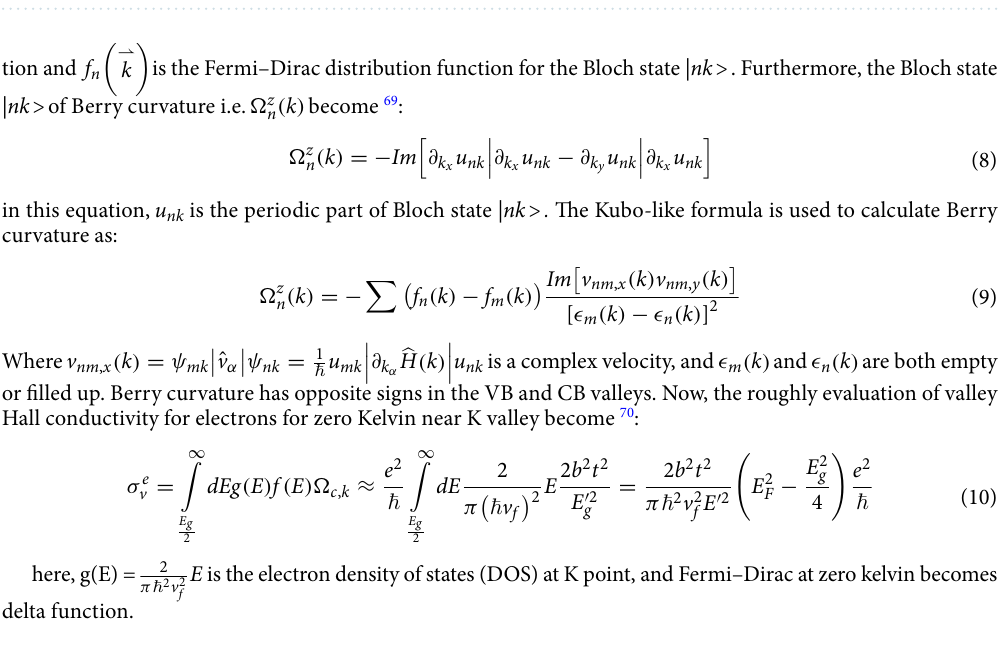
Figure 2. Electronic band structure of MoX 2 (X = S, Se, Te) for two types of strain labeled as uniaxial X-tensile and Y-arc strain with c = = 0, 0.04,